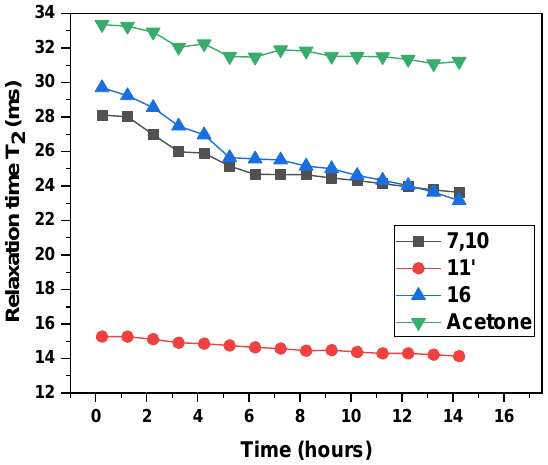
Figure 4. Time dependence of the T 2 relaxation times of the polyurethane mixture in acetone measured after the polyaddition and neutralization reactions (calculated from the linewidths using the relation T 2 = ( π Δ ν ) −1 ).